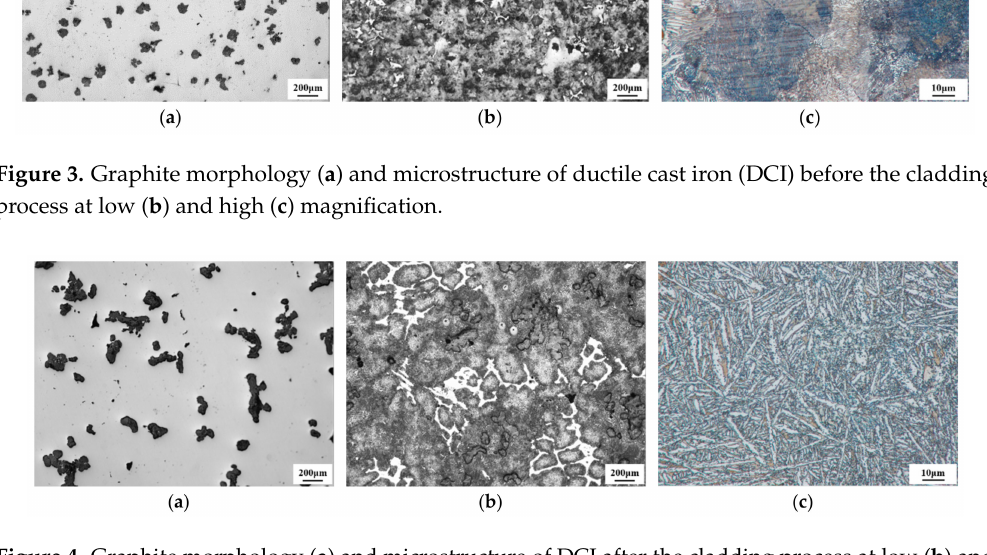
Figure 4. Graphite morphology ( a ) and microstructure of DCI after the cladding process at low ( b ) and high ( c )